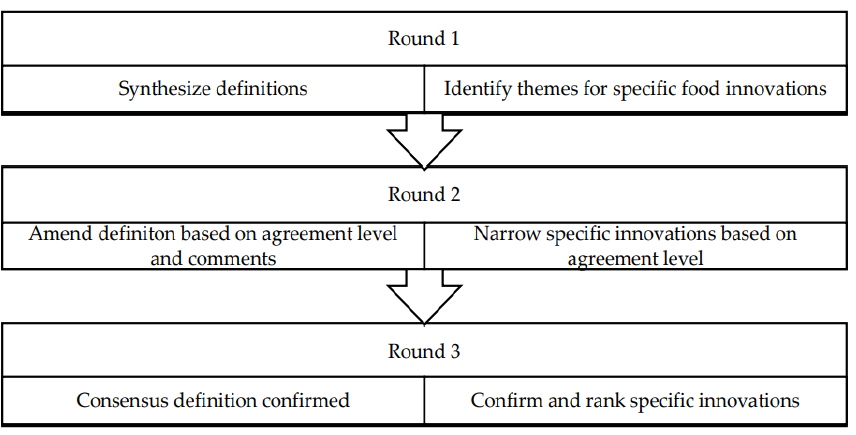
Figure 1. Methodology for the Delphi Study.